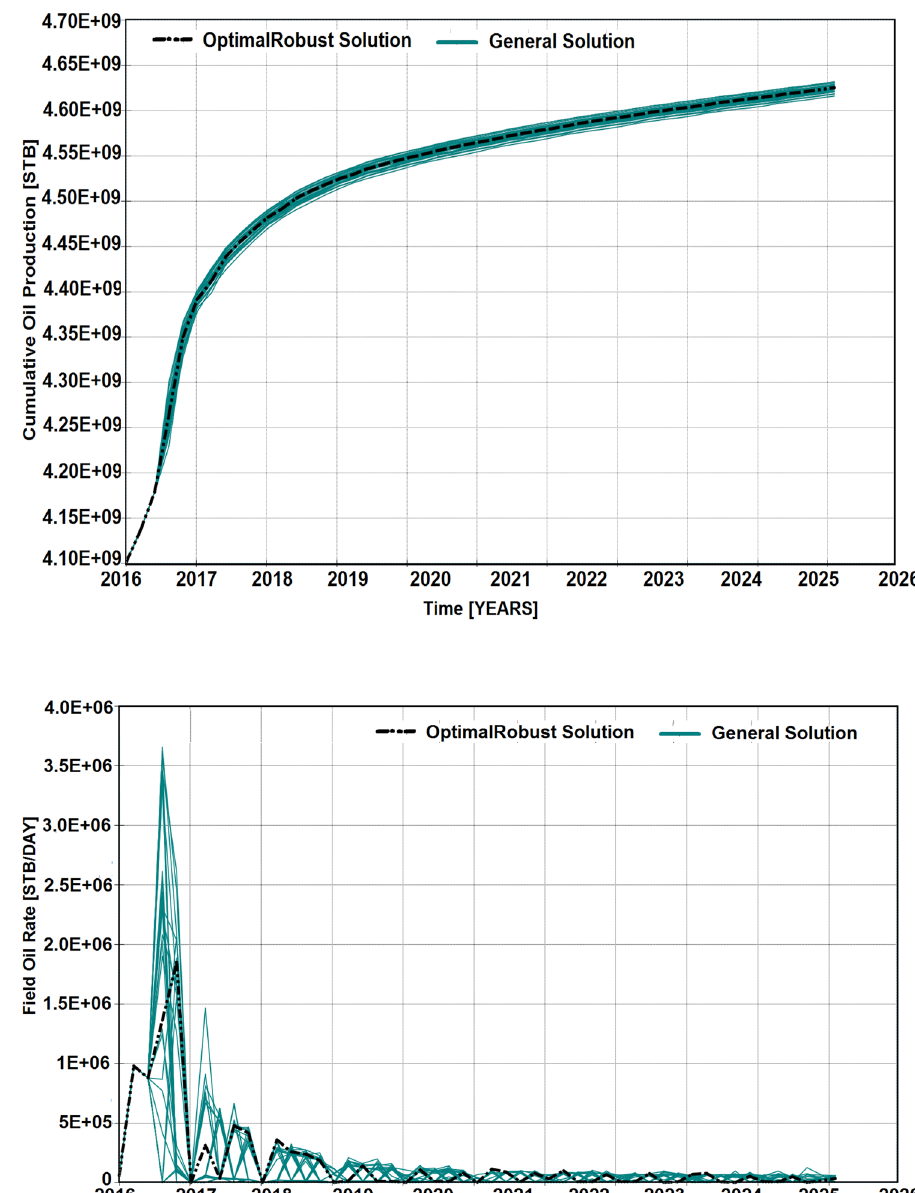
Fig. 15 Reservoir flow responses under production Huff and Puff uncertainty